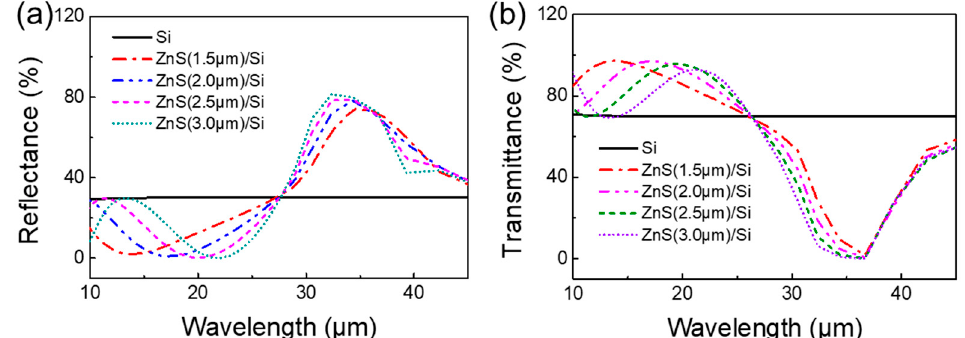
Figure 2. ( a ) Reflectance and ( b ) transmittance spectra of the Si and ZnS/Si structures simulated with FDTD, in which the thickness of the ZnS layer was set to 1.5, 2.0, 2.5, and 3.0 µ m, respectively.